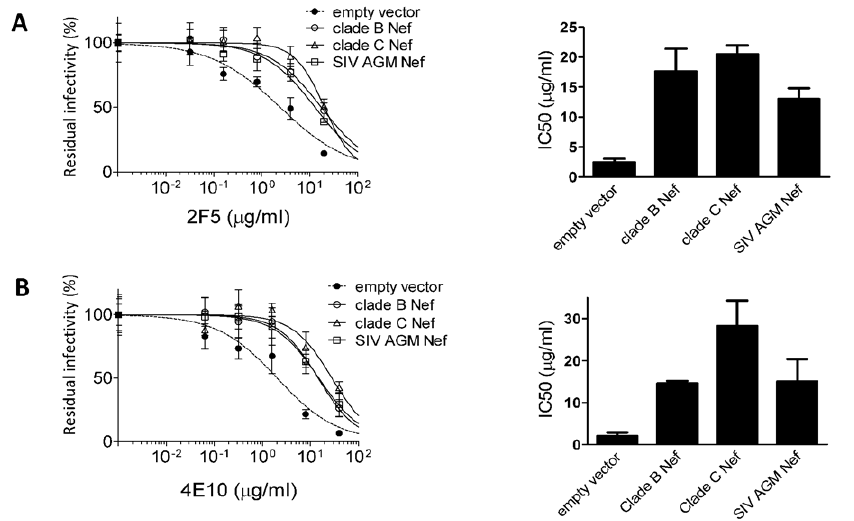
Figure 7. The effect of Nef on neutralization is conserved among different Nef alleles. Neutralizion of HIV-1 HXB2 by 2F5 (A) and neutralization of HIV-1 NL4-3 pseudotyped with Env JRFL neutralized by 4E10 (B). IC50 derived from the sigmoidal curves are shown on the right. As indicated, nef alleles were expressed in trans in producer cells. Neutralization was performed three times independently. Shown are the mean values and